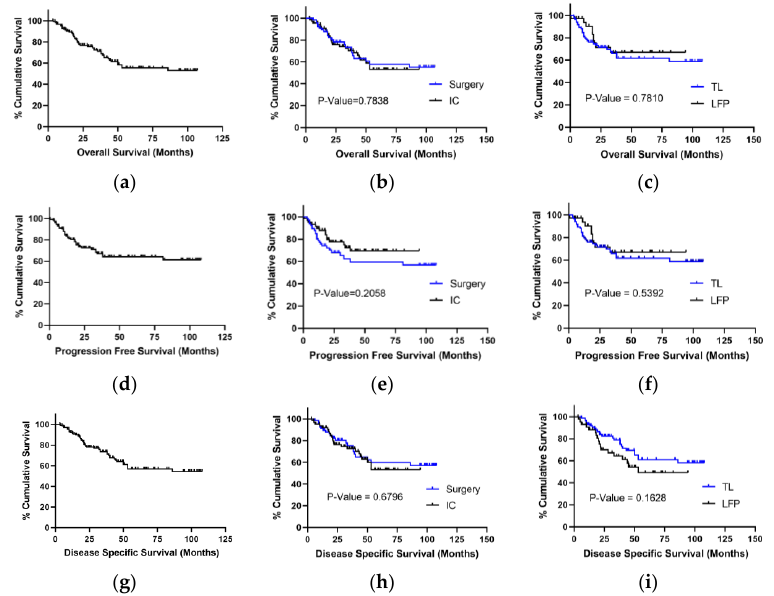
Figure 8. K-M analysis of OS, progression-free survival (PFS), and disease specific survival (DSS) in LSCC patients with a log-rank test. ( a ) K-M analysis of OS in all patients; ( b , c ) K-M analysis of treat- ment and laryngeal function preservation (LFP) or total laryngectomy (TL) for OS; ( d ) K-M analysis